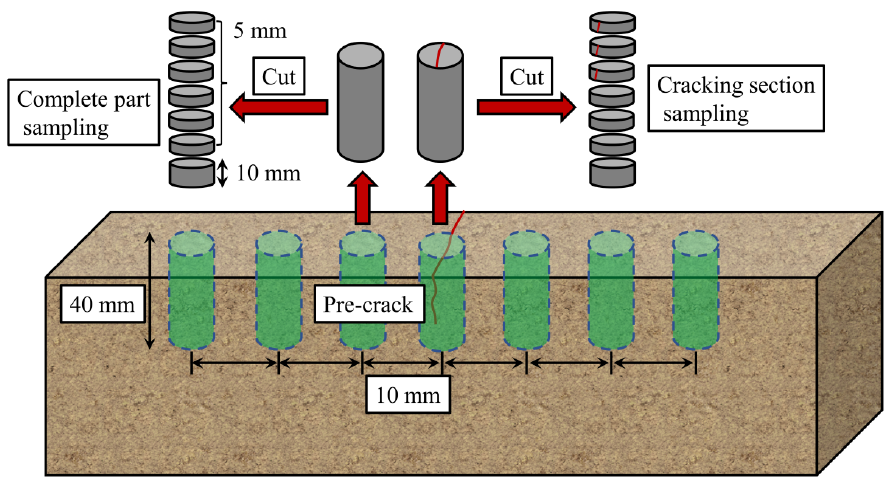
Figure 4. Experimental samples.